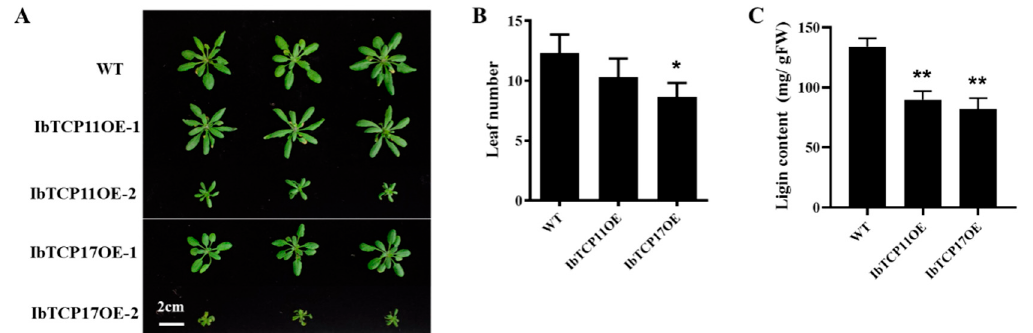
Figure 5. Phenotypes of transgenic Arabidopsis plants. ( A ): The transgenic plants (IbTCP11-OE and IbTCP17-OE) exhibited a smaller plant structure and leaf to the WT controls. Photographs of representative seedlings of WT and two transgenic lines were taken. ( B ): Leaf number in IbTCP11OE and IbTCP17OE transgenic plants and WT ( n = 20). ( C ): Lignin content in IbTCP11-OE and IbTCP17-OE transgenic plants and WT ( n = 10). *,** indicate significant differences between transgenic and control plants at p < 0.05, 0.01.